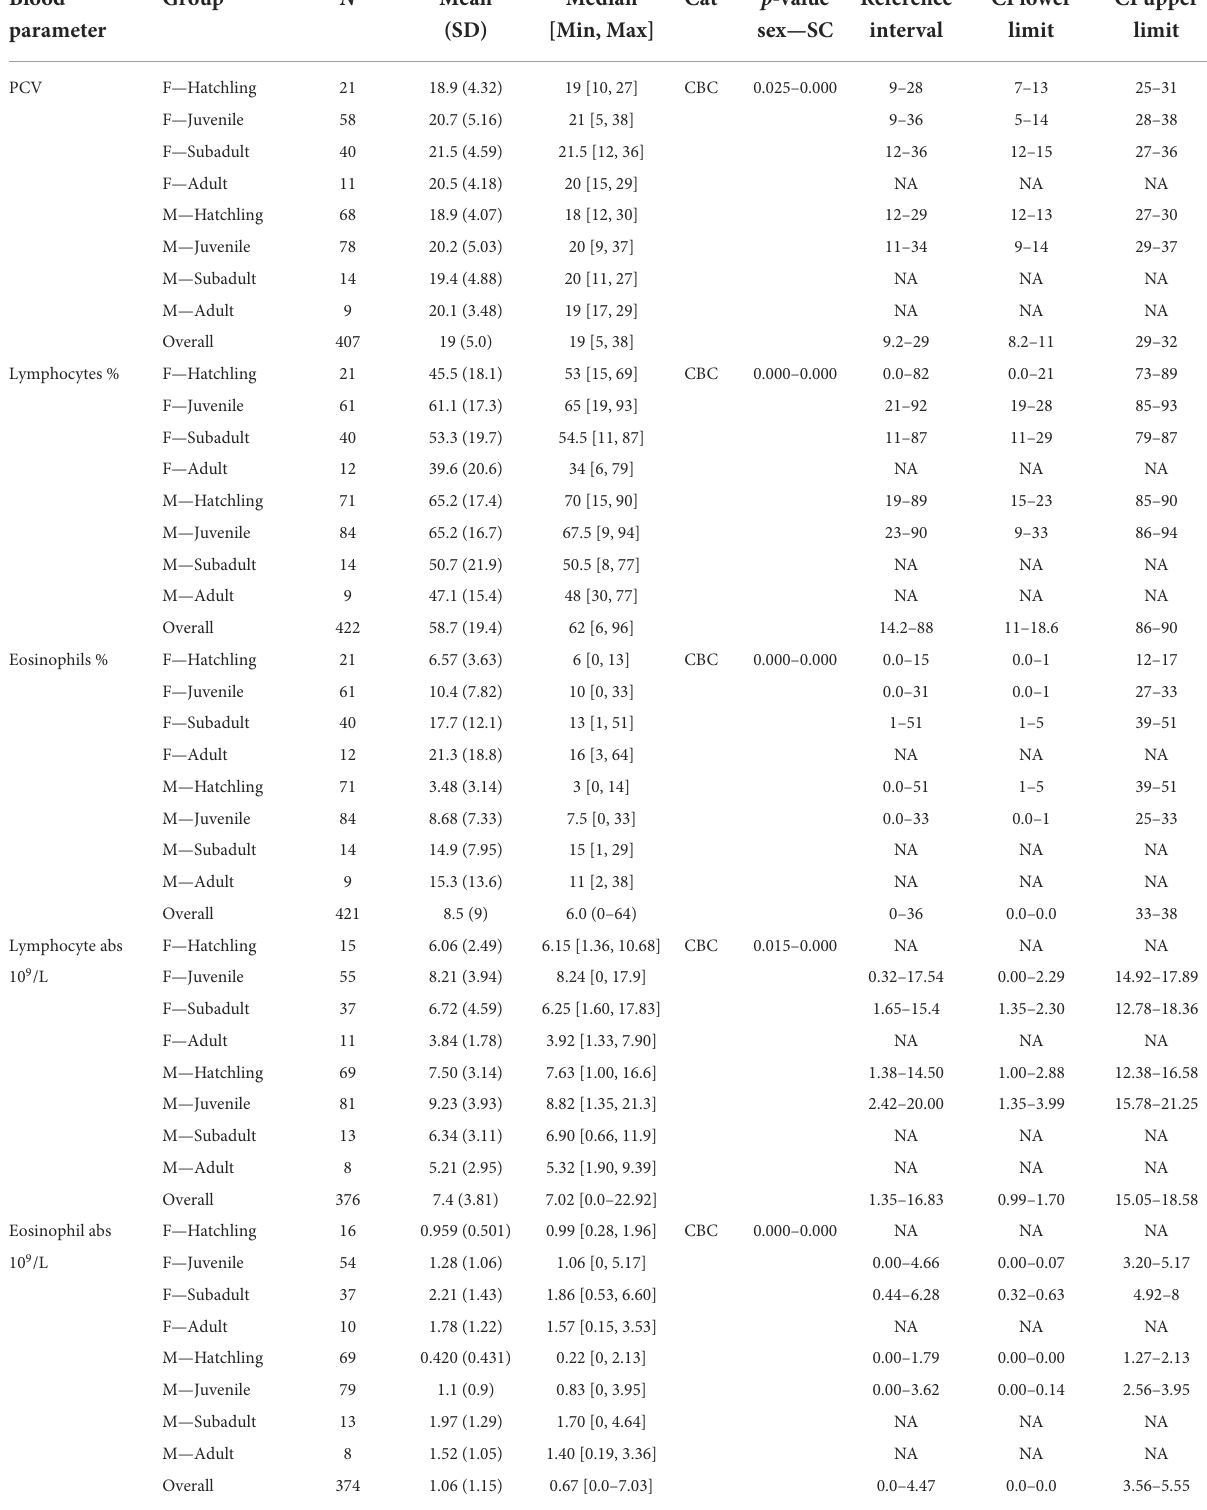
TABLE 4 Hematological and biochemical general statistics and reference values with 90% confidence intervals (CI) for wild American crocodile ( Crocodylus acutus ) analytes that showed statistical evidence of being affected by both sex and size class in South Florida, United States. Blood